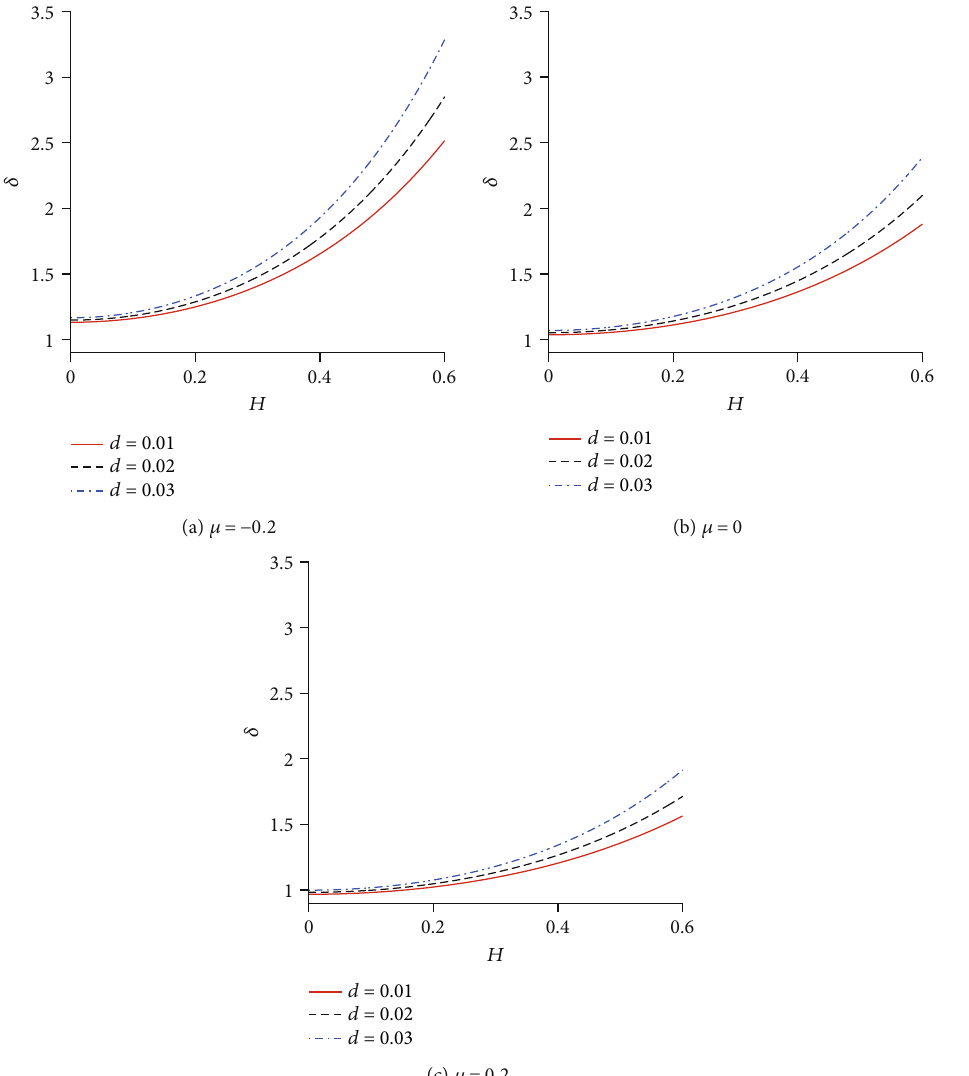
Þ for di ff erent wave amplitude μ 0